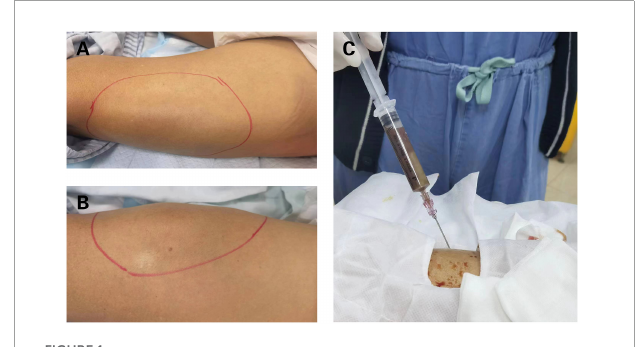
FIGURE1 Clinical manifestation of bilateral thighs abscesses. (A) Bulging mass on the right thigh. (B) Bulging mass on the left thigh. (C) Brown fetid pus was aspirated by computed tomography (CT)-guided percutaneous puncture in right thigh abscess.